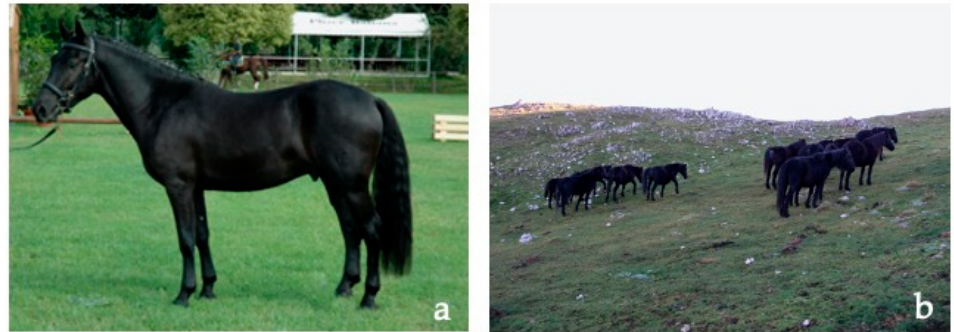
Figure 1. ( a ) Pony of Esperia. ( b ) Grazing herd of Pony of Esperia. This breed is reared in the wild and it stays in the pastures throughout the year.